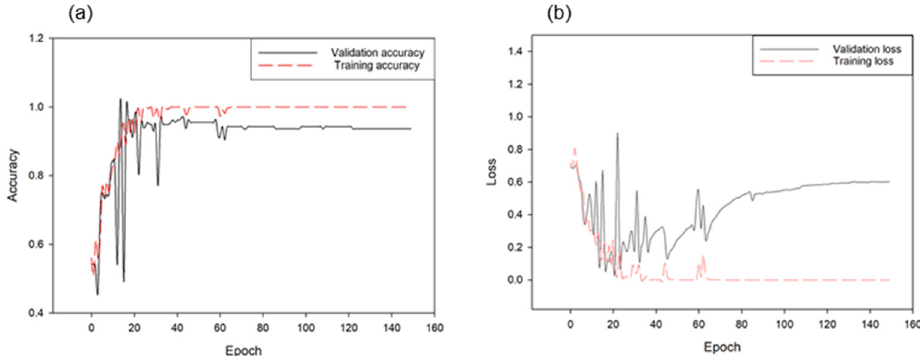
Figure 10. Accuracies of training and validation for the CNN model for classifying cattle voices and other sounds ( a ) as well as corresponding loss changes ( b ) (1.0 is 100% accuracy in this graph).